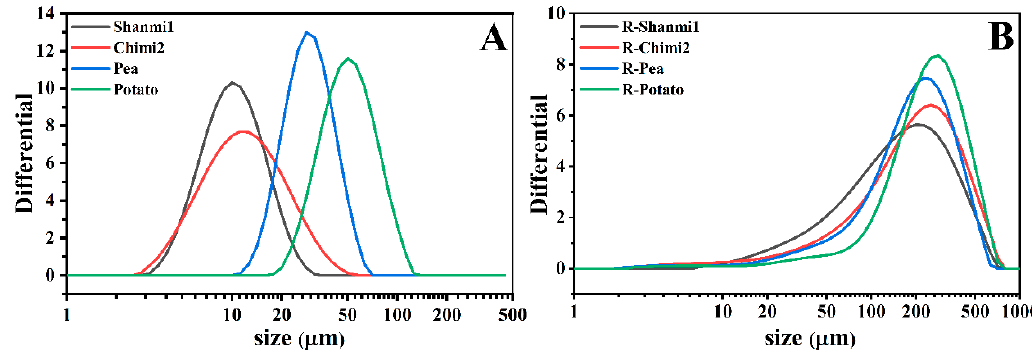
Figure 2. ( A ) Grain size distribution of NS (natural starch); ( B ) Grain size distribution of RS (resistant starch). Table 1. Granule size and color values of NS (natural starch) and RS (resistant starch) a . Granule Size b Color Values c Varieties and Lines d (0.5) µ m D (3, 2) µ m D (4, 3) µ m L*